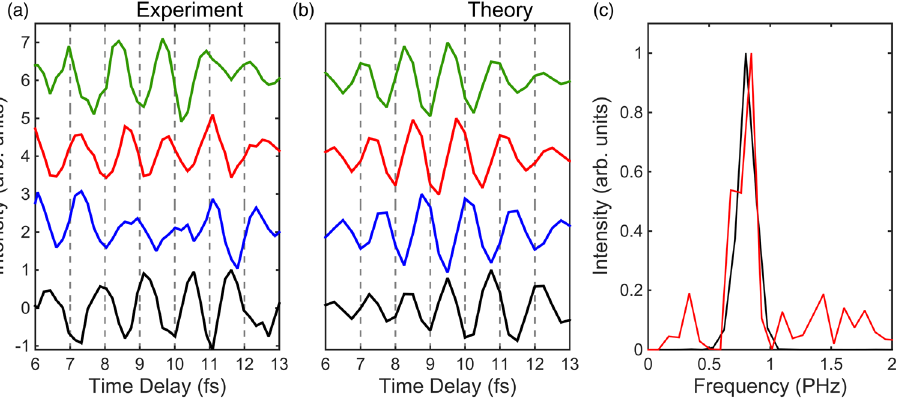
FIG. 6. Oscillatory pattern obtained after subtraction of a fifth-order polynomial fitting curve to filter out the slow dynamics in both the experimental (a) and the theoretical (b) data around 0.8 eV (black curve), 1.6 eV (blue curve), 1.9 eV (red curve), and 2.2 eV (green curve). (c) Fourier transform power spectrum of the experimental curve (red line) and the theoretical curve (black line) around 2.2